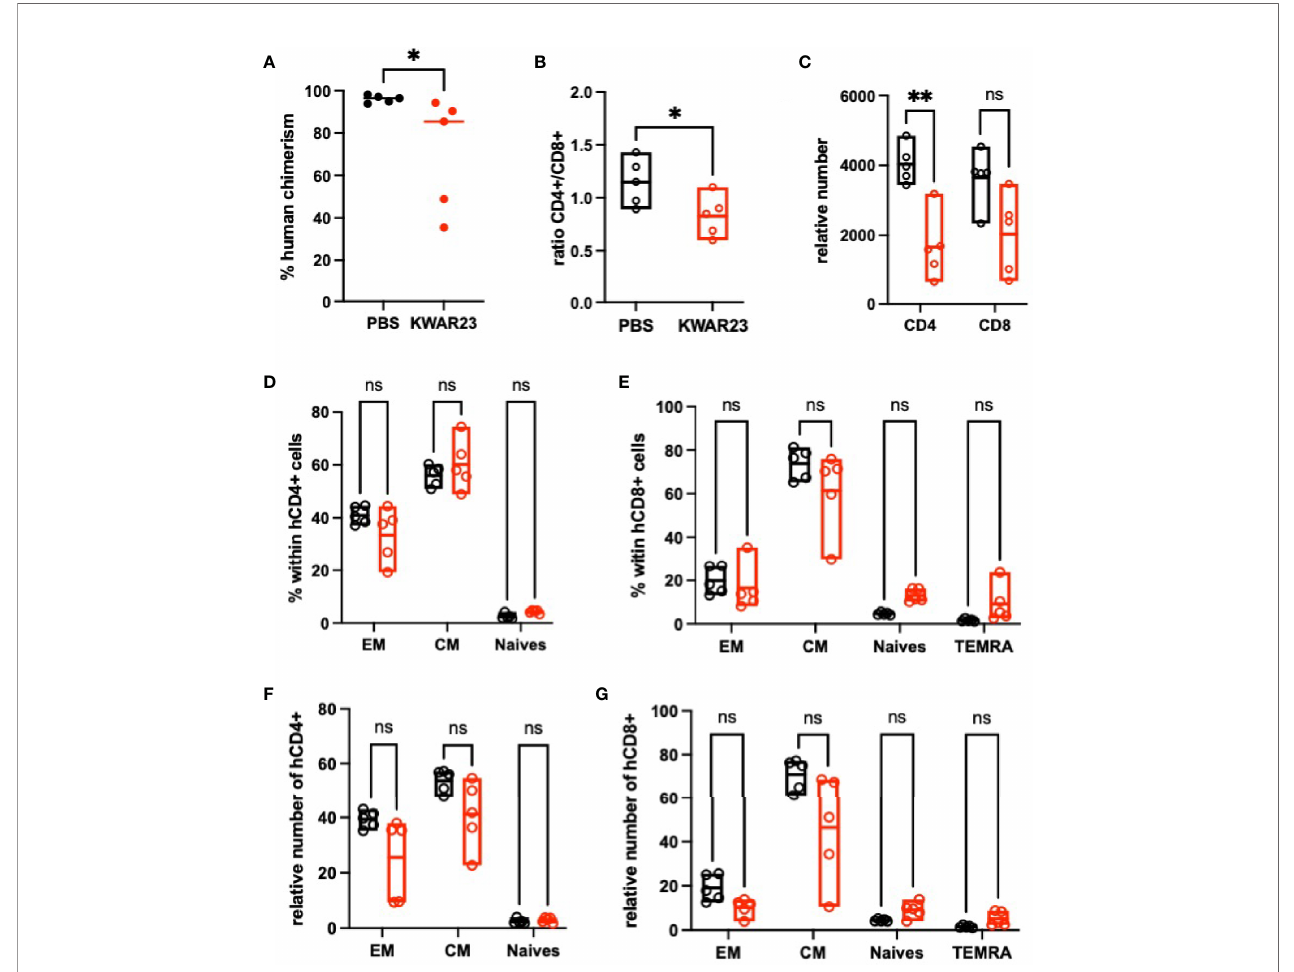
FIGURE 8 | Inhibition of SIRP a - g /CD47 interactions alters memory cells in the spleen of humanized mice. At Day 14, splenocytes were analyzed by FACS. (A) Human chimerism is shown; data were analyzed with a Mann-Whitney test. (B) CD4/CD8 ratio is shown regarding the treatment; data were analyzed with a Mann-Whitney test. (C) Relative number of human CD4 and CD8 in the splenocytes of recipient mice at Day 14. Data were analyzed with a one-way ANOVA test followed by Kruskal-Wallis. (D) Percentage of human CD4 and (E) CD8 subpopulations is presented based on FACS analysis with the following patterns CD45RA − CD27 − effector memory cells (EM), CD45RA − CD27 + central memory cells (CM), CD45RA + CD27 + -naïve cells, and CD4 − CD45RA + CD27 − for TEMRA CD8 cells. (F) Relative number of each subpopulation of CD4 + and (G) CD8 + T cells are presented. n = 1 experiment with PBMC from one HV. Data were analyzed with a one-way ANOVA test followed by Kruskal-Wallis. * p ≤ 0.05; ** p ≤ 0.01; ns, not signi fi